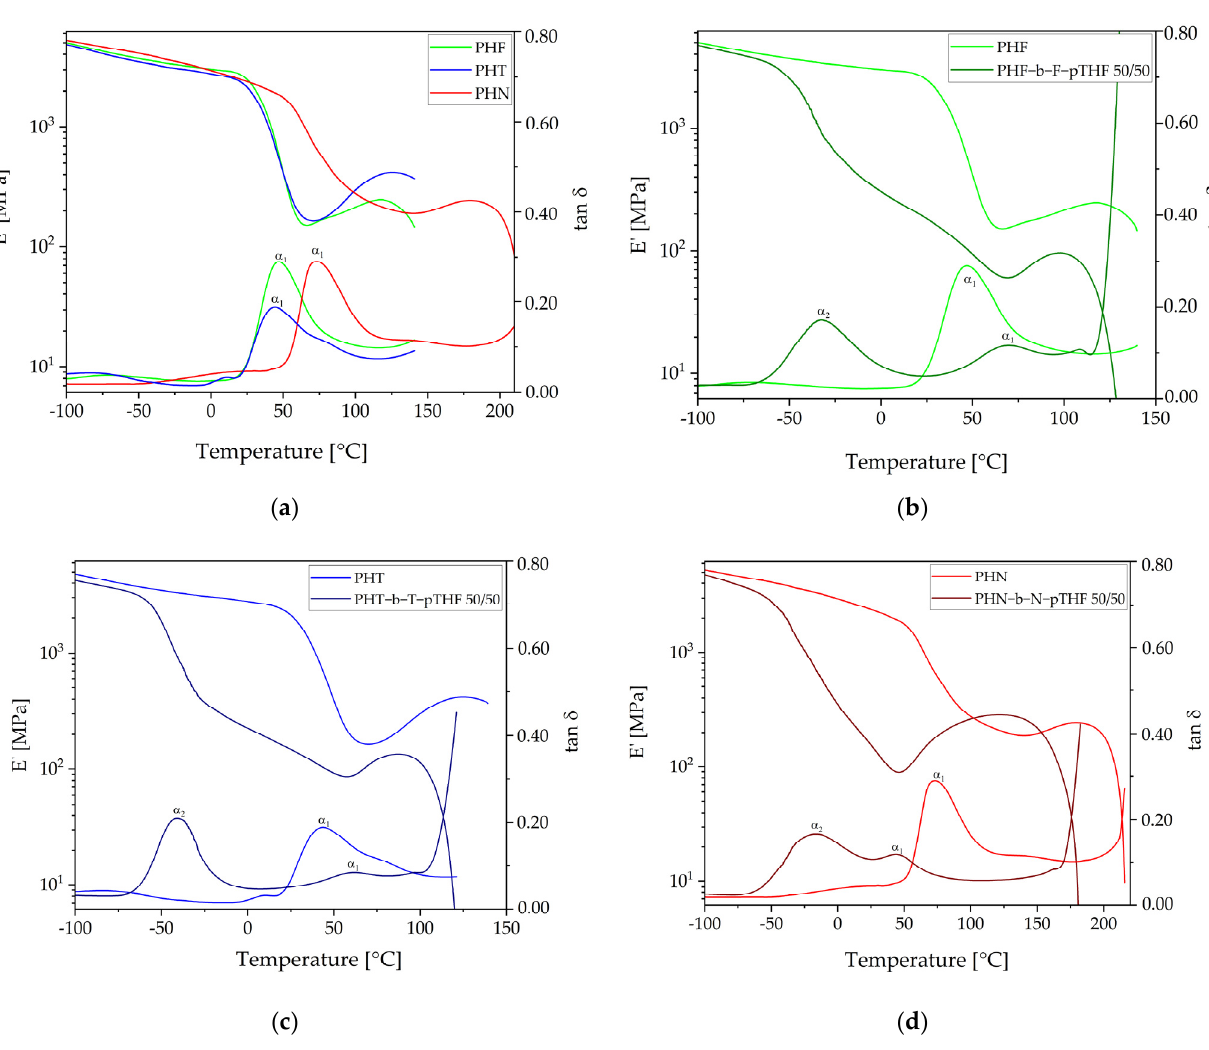
Figure 11. The storage modulus E’ ( a , c ) and tan δ ( b , d ) as a function of temperature for polyesters and copoly(ether-ester)s. Table 5. Properties determined from DMTA analysis for synthesized polyesters and copolymers. Sample